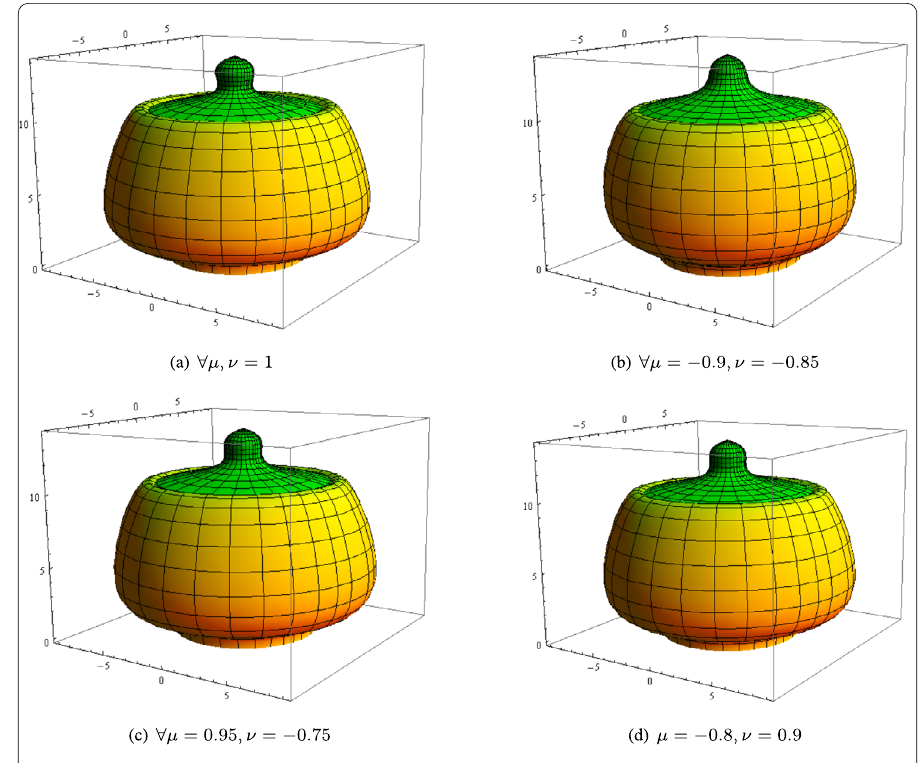
Figure 27 Modeling examples of a pot with different shape parameters